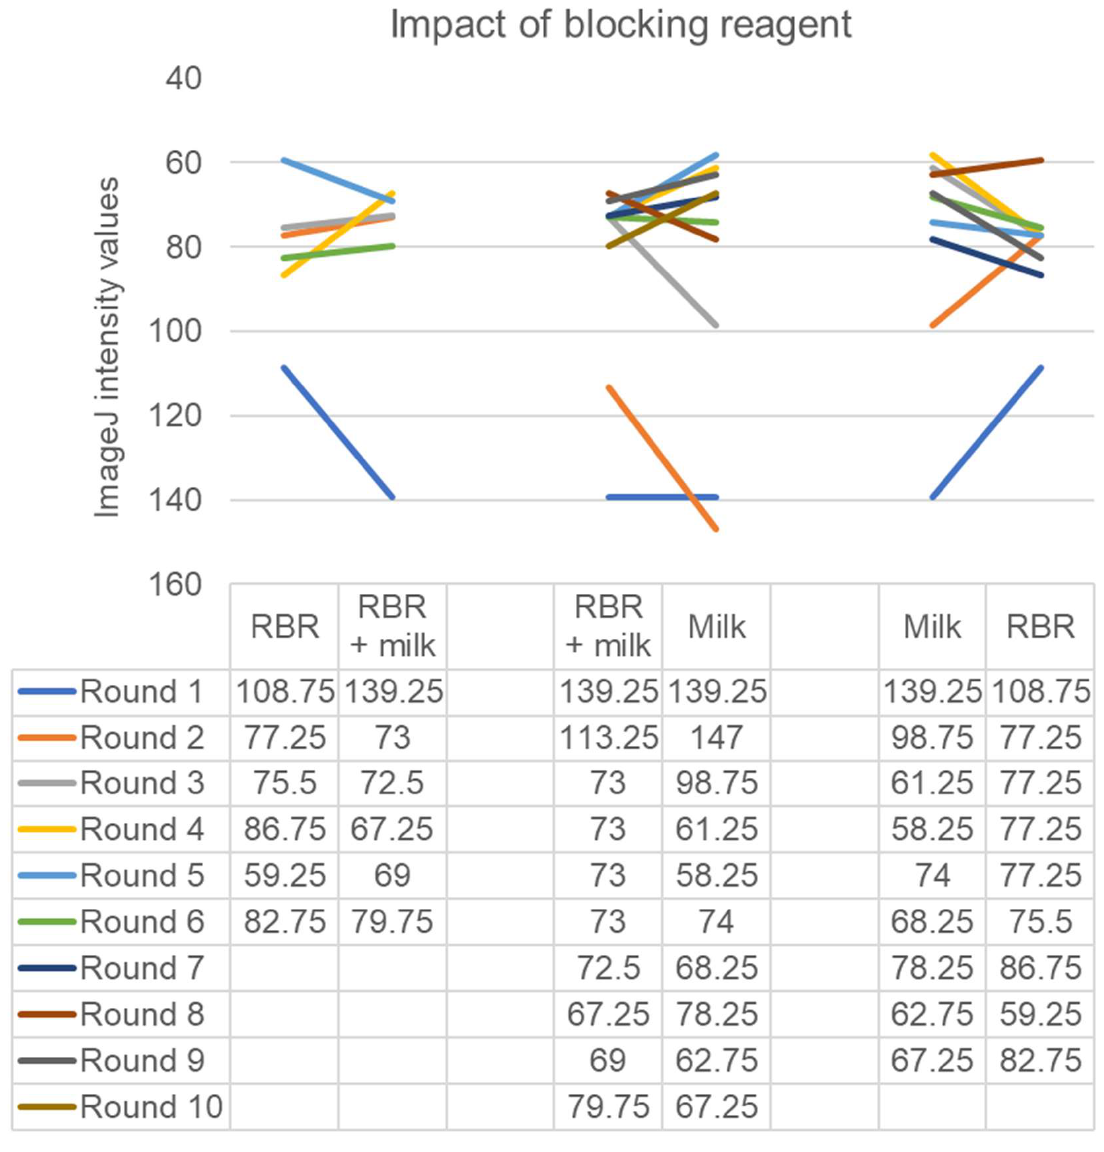
Figure 3. ImageJ intensity values for AP- tdh probes paired by blocking conditions. Base hybridization buffers contained 5X SSC.8, 0.5% PVP, and 1% SDS as a base. To this base were added RBR, RBR + 5% milk (RBR + milk), or 5% milk alone (Milk).